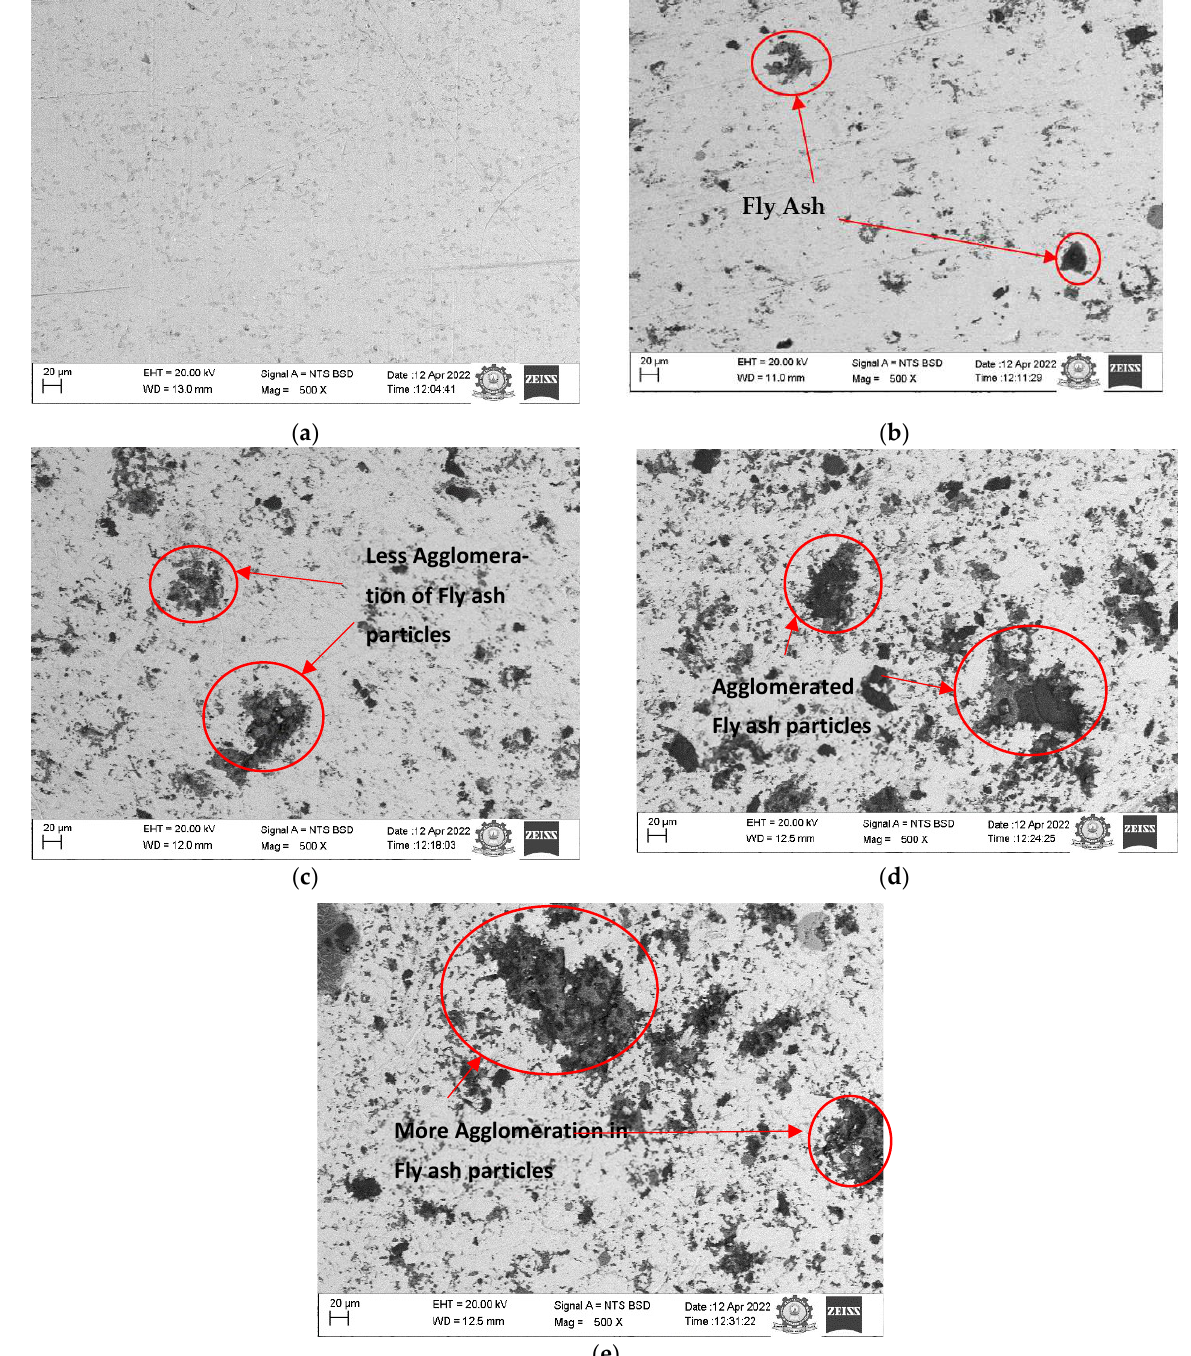
Figure 3. SEM of copper with different proportions of fly ash: ( a ) copper without reinforcement; ( b ) copper with 2.5% fly ash; ( c ) copper with 5.0% fly ash; ( d ) copper with 7.5% fly ash; ( e ) copper with 10.0% fly ash.